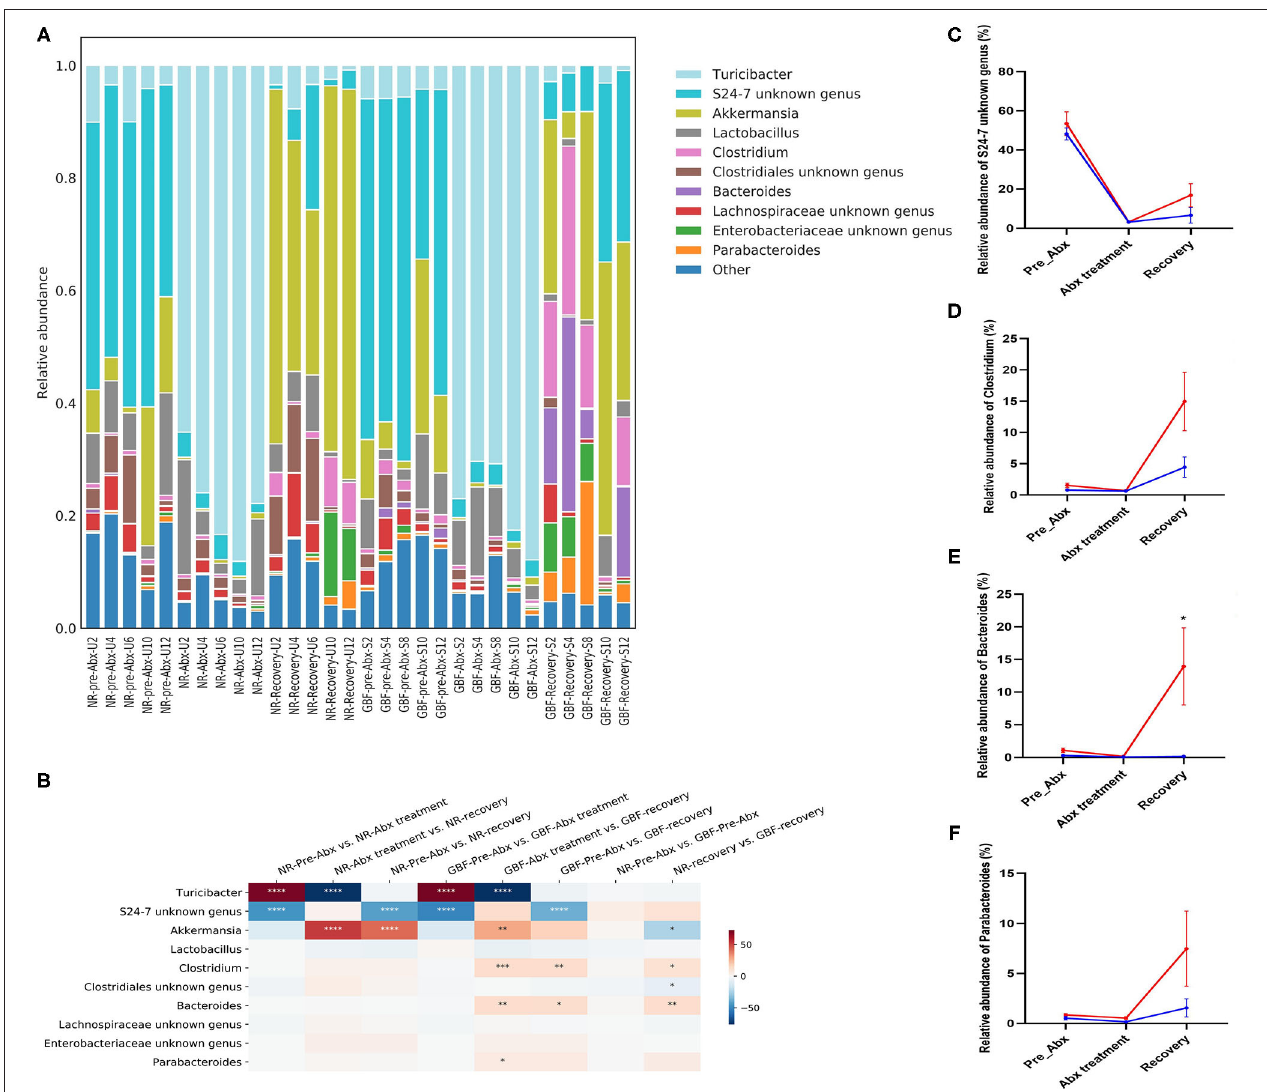
FIGURE 7 | Gut microbiota composition differences at the genus level. (A) Microbiota composition differences. (B) Only the 10 more abundant genera were represented and compared. Significance was determined using one-way analysis of variance corrected for multiple comparisons with a Tukey’s test, n = 5 per group. * P < 0.05, ** P < 0.01, *** P < 0.001, **** P < 0.0001. (C–F) The relative abundance of S24-7 unknown genus, Clostridium, Bacteroides , and Parabacteroides from both groups were compared throughout the experiment. Significance was determined using two-tailed unpaired t -tests. The values are expressed as the means ± SEM, n = 5 per group. * P <